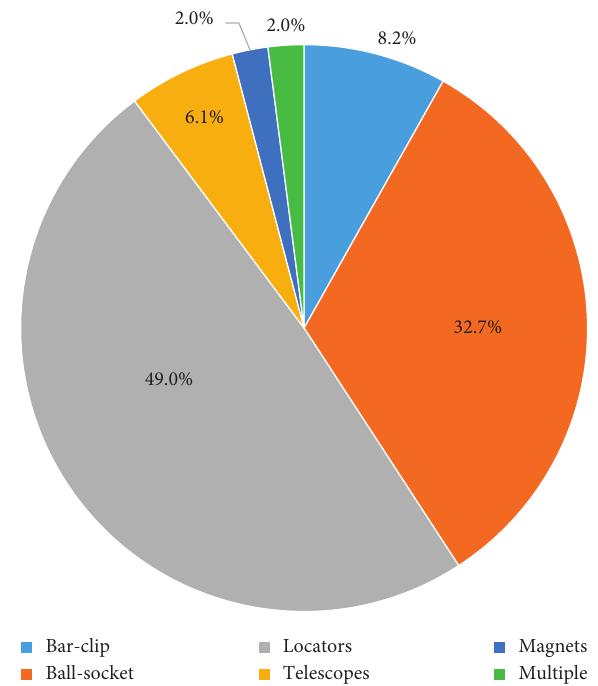
Figure 2: The types of attachments for implant-retained/supported